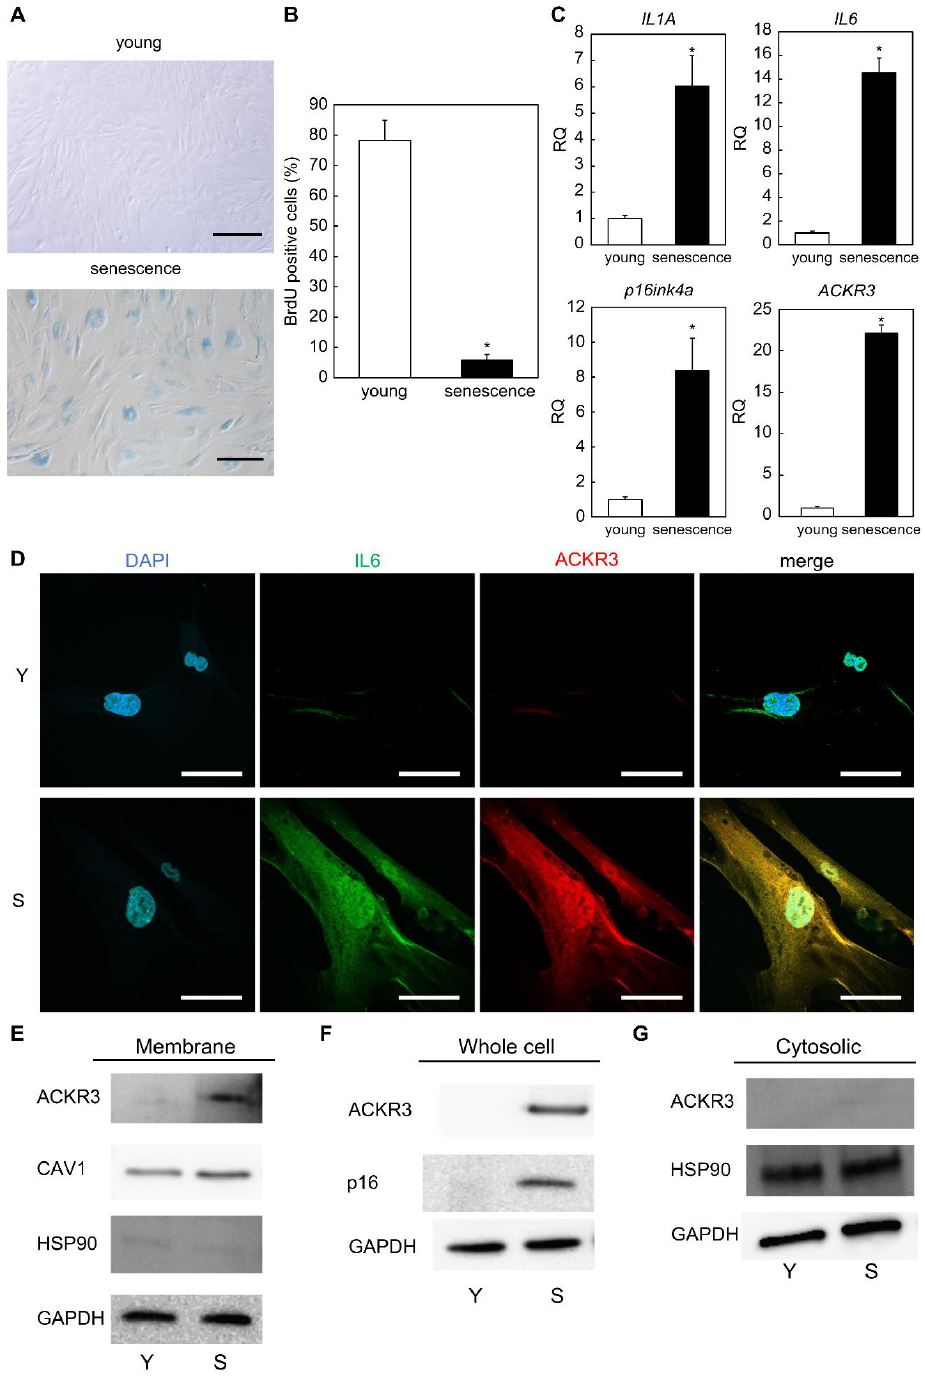
Figure 1. Identification of ACKR3 as a novel senescent cell surface marker protein. ( A ) SA- β -gal staining of proliferating and senescent cells. Bar = 50 µm. ( B ) BrdU absorption by proliferating and senescent cells. ( C ) Real-time quantitative polymerase chain reaction (RT-qPCR) analysis of the ex- pression of senescence-related genes using cell extracts. GAPDH was used as the housekeeping gene. ( D ) Immunostaining of IL6 and ACKR3 in young (proliferating) and senescent cells. Bar = 20 µ m. Y: young cells. S: senescent cells. ( E ) Western blot analysis of cell extract proteins. ( F ) Western blot analysis of whole-cell lysate proteins. ( G ) Western blot analysis of cytosolic proteins. GAPDH was used as the housekeeping protein. *; p < 0.05. RQ; relative quantification. All experiments were repeated in